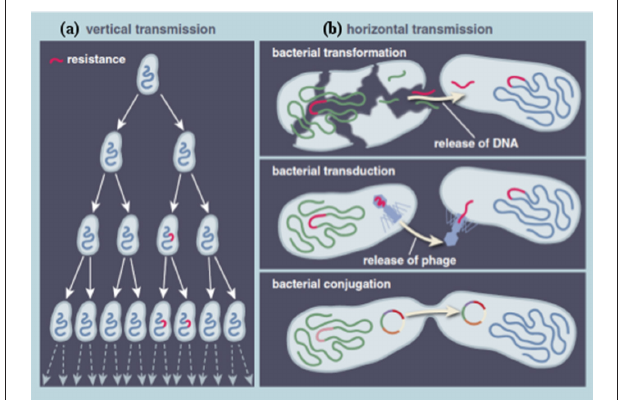
FIGURE 1 | Principal biological pathways involved in the evolution and development of antibiotic resistance. (A) Vertical transmission (B) Horizontal transmission. Reprinted by permission from American Scientist ( Dantas and Sommer, 2014), Copyright